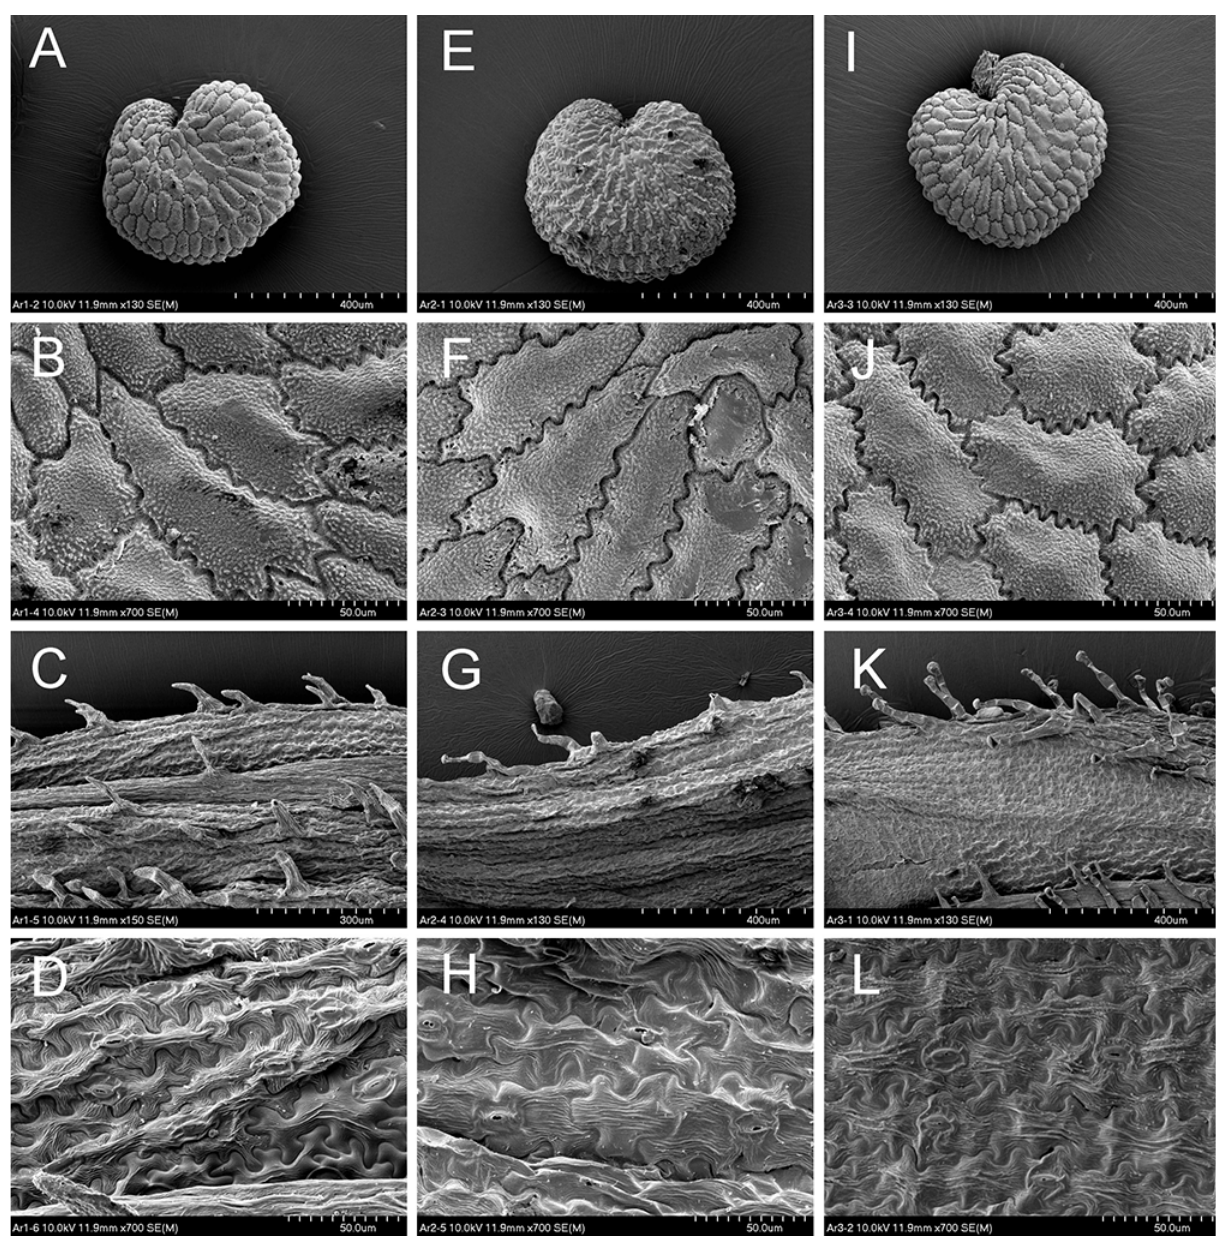
Fig. 5 Micromorphology of seeds [shape of seed ( A,E,I ); sinuous side walls of the basal cells ( B,F,J )] and calyxes [eglandular, mixed, and glandular hairs on the abaxial surface of calyx ( C,G,K ); deeply sinuous slide walls of the calyx basal cells ( D,H,L )] in Arenaria serpyllifolia s. l.: ( A–D ) morphotype SERP; ( E–H ) morphotype MIX; ( I–L ) morphotype